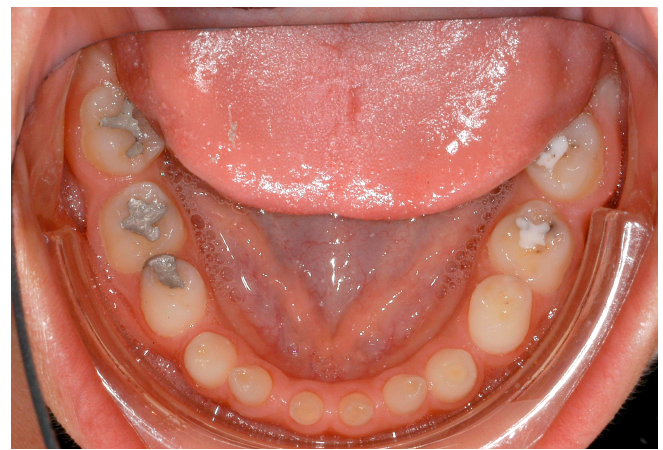
Figure 9. Intraoral situation: oligodontia, microdontia of teeth 11 and 21.